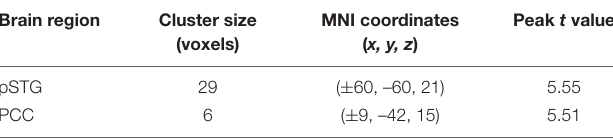
TABLE 2 | Significant clusters on VMHC